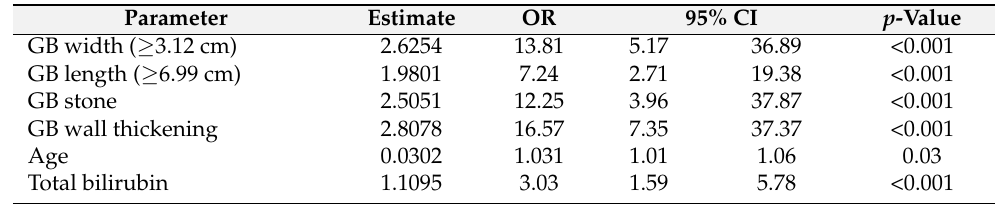
Table 3. Multivariable analysis for CT findings and clinical data affecting acute